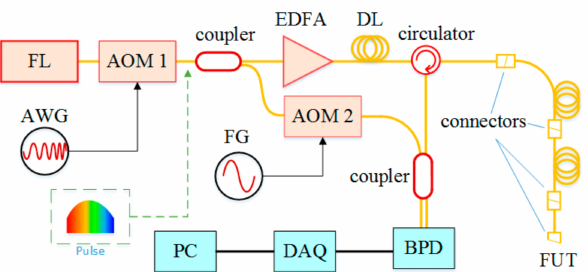
Figure 1. Systemic configuration. FL: fiber laser; AOM: acousto-optical modulator; AWG: arbitrary waveform generator; FG: function generator; EDFA: Er-doped fiber amplifier; DL: fiber delay line; FUT: fiber under test; BPD: balanced photo-detector; DAQ: data acquisition; PC: personal